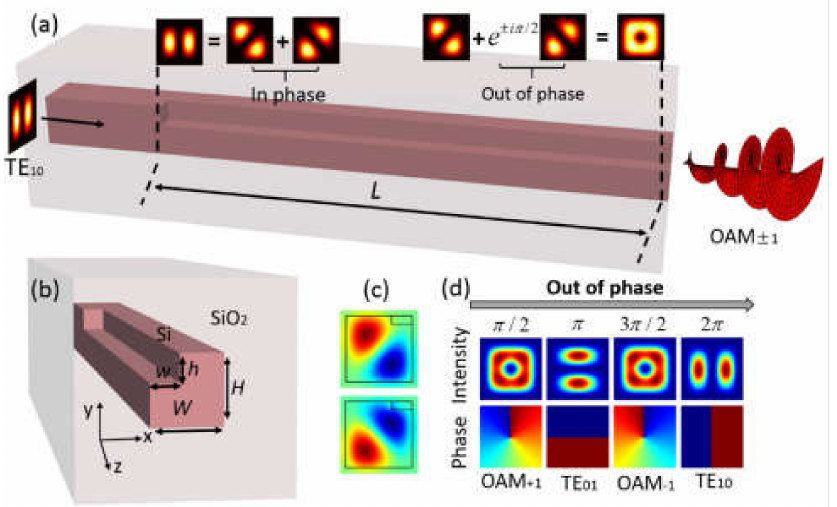
Figure 14. ( a ) OAM beam generator principle built on a single-trench WG; ( b ) A single trench WG in cross-section; ( c ) Two eigenmodes of a single-trench WG’s field distributions; and ( d ) For x -polarization, intensity and phase evolutions of a combination of eigenmodes